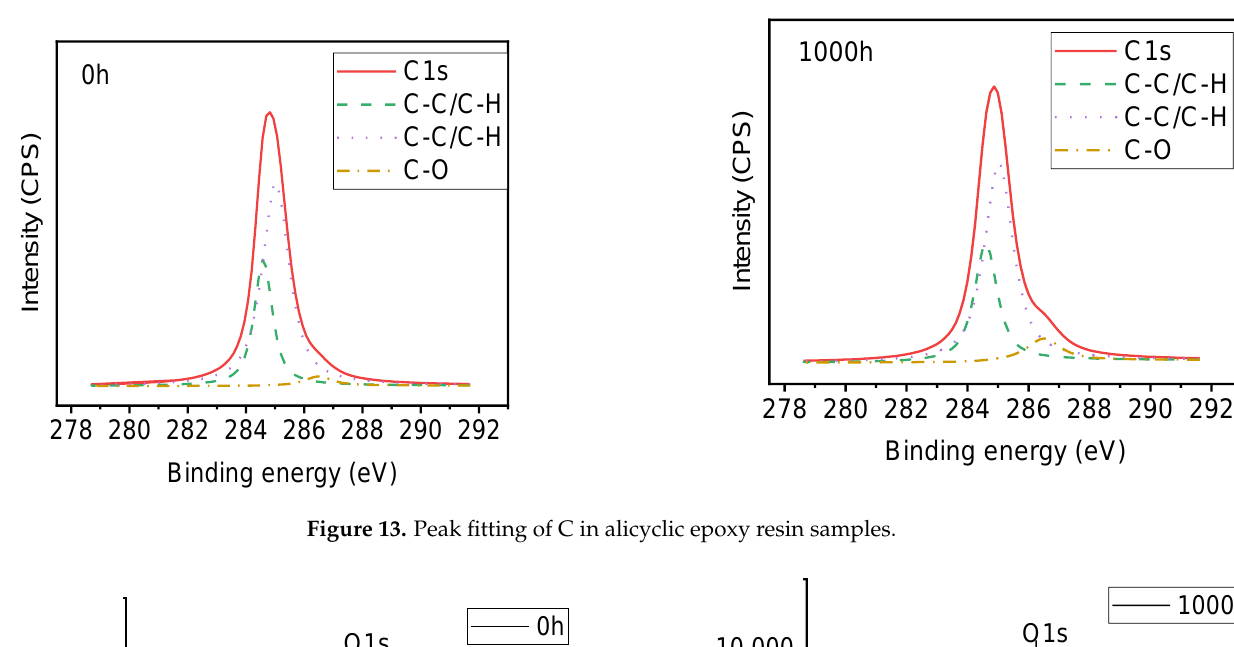
Figure 12. The XPS result of alicyclic epoxy resin samples.